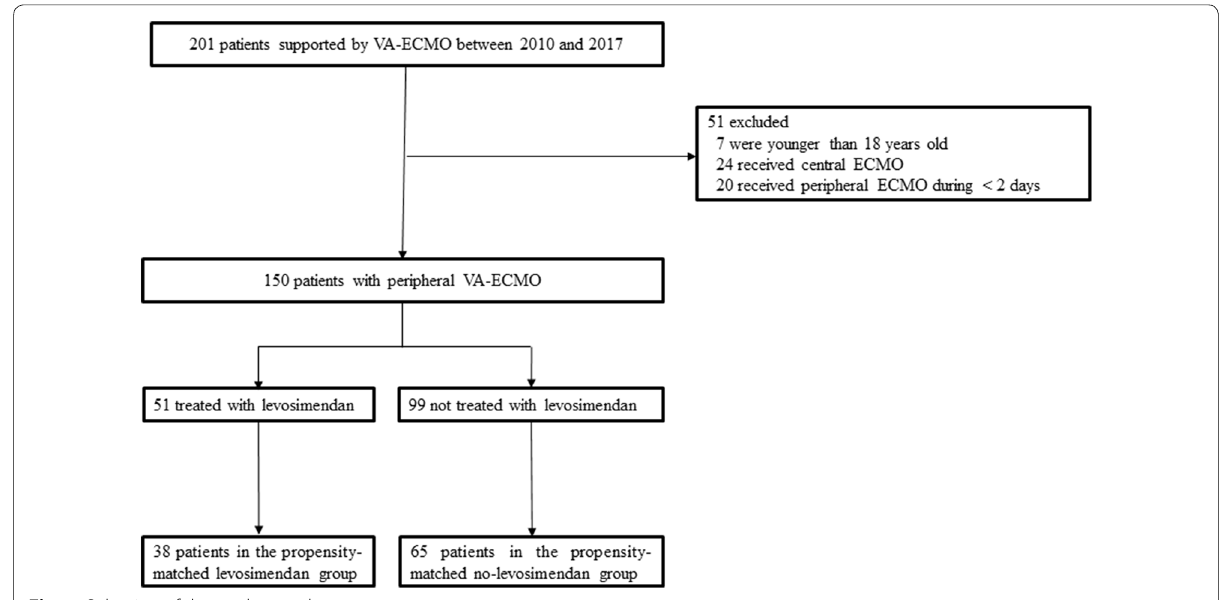
Fig. 1 Selection of the study